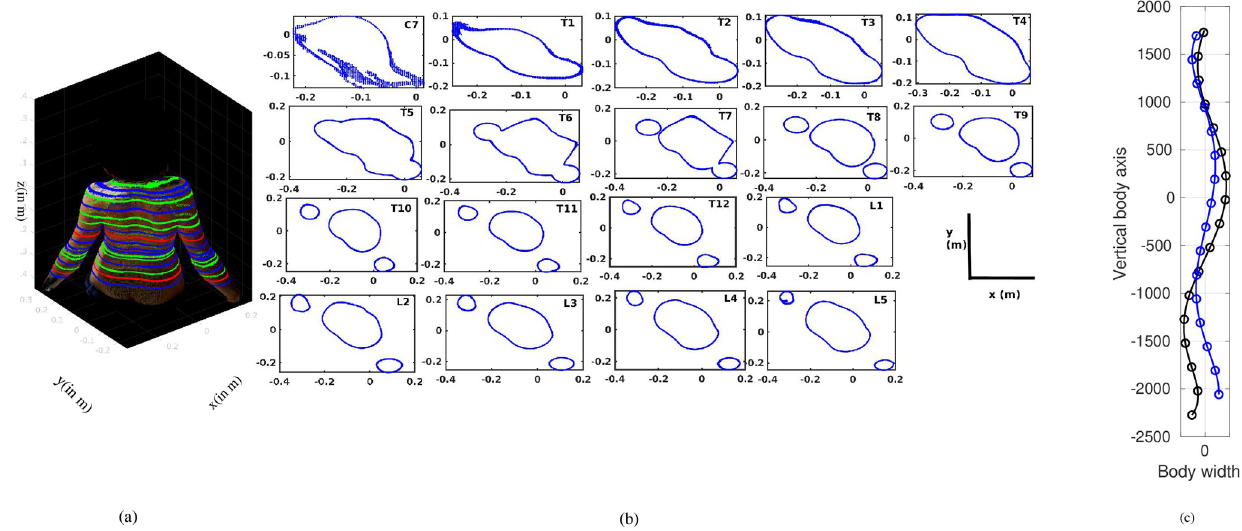
Fig 1. Scan image. (a) 3D scan image of a patient captured by a body scanner and the transverse body contours marked at different vertebral levels along the vertical body axis. (b) Extracted transverse body contours at vertebral levels from C7 to L5. C7 is the seventh cervical vertebra, T1–T12 indicates twelve thoracic vertebrae, L1—L5 are lumbar vertebrae. (c) Vertebral courses extracted from X-ray images: black line at the time of first visit, blue line at the time of one of the follow-up examinations.